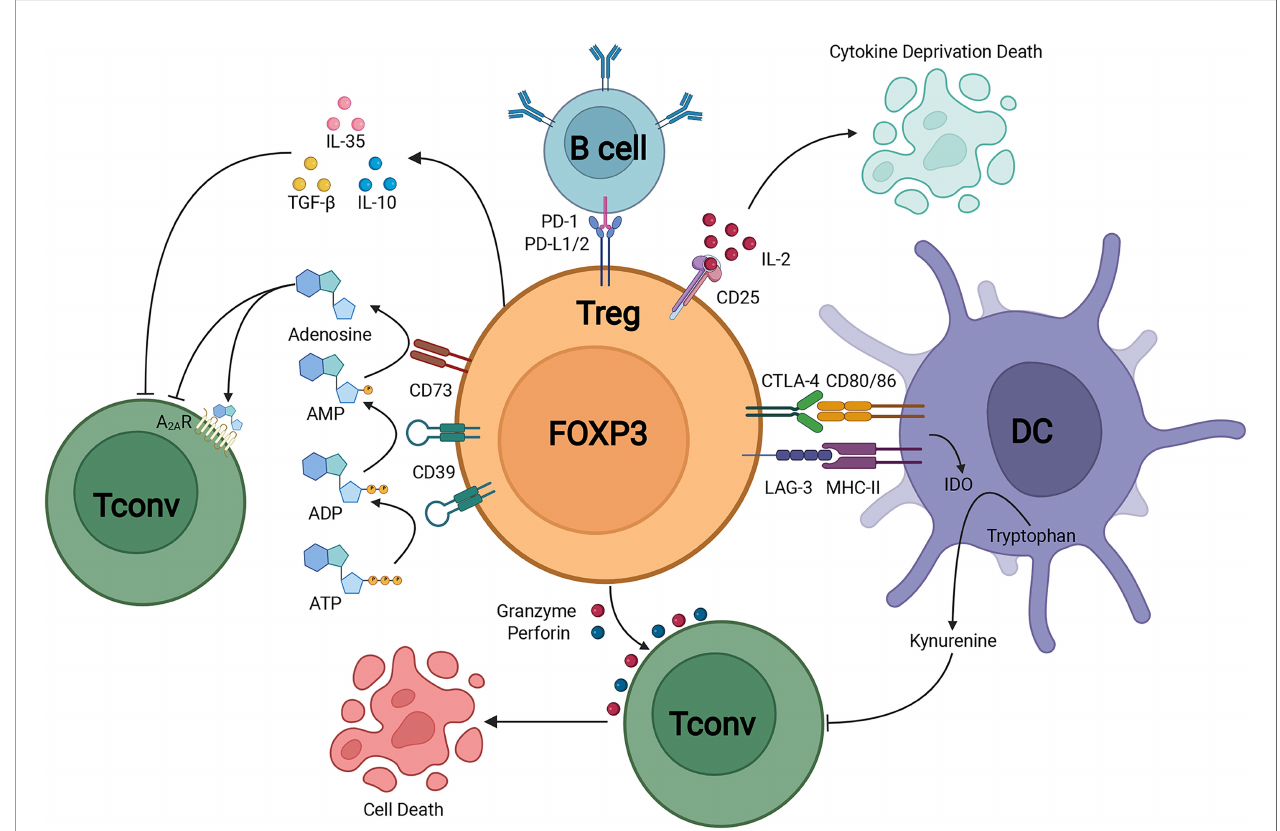
FIGURE 1 | Treg suppressive mechanisms.Treg could secrete immunosuppressive cytokines including IL-10, TGF- b , and IL-35. In addition, Treg could induce cytolysis by Granzyme-dependent and Perforin-dependent mechanisms. The CD25 on Treg competitively binds to IL-2 and mediates apoptosis of effector immune cells through cytokine-deprivation. The interaction of LAG-3 and MHC-II mediates suppression of DC maturation, the interaction of CTLA-4 and CD80/86 mediates the production of immunosuppressive molecule IDO in DC. CD39 and CD73 facilitate the generation of pericellular adenosine, whose suppressive function is mediated through A 2A R. Treg inhibits B cell activity via the interaction of PD-L1/2 and